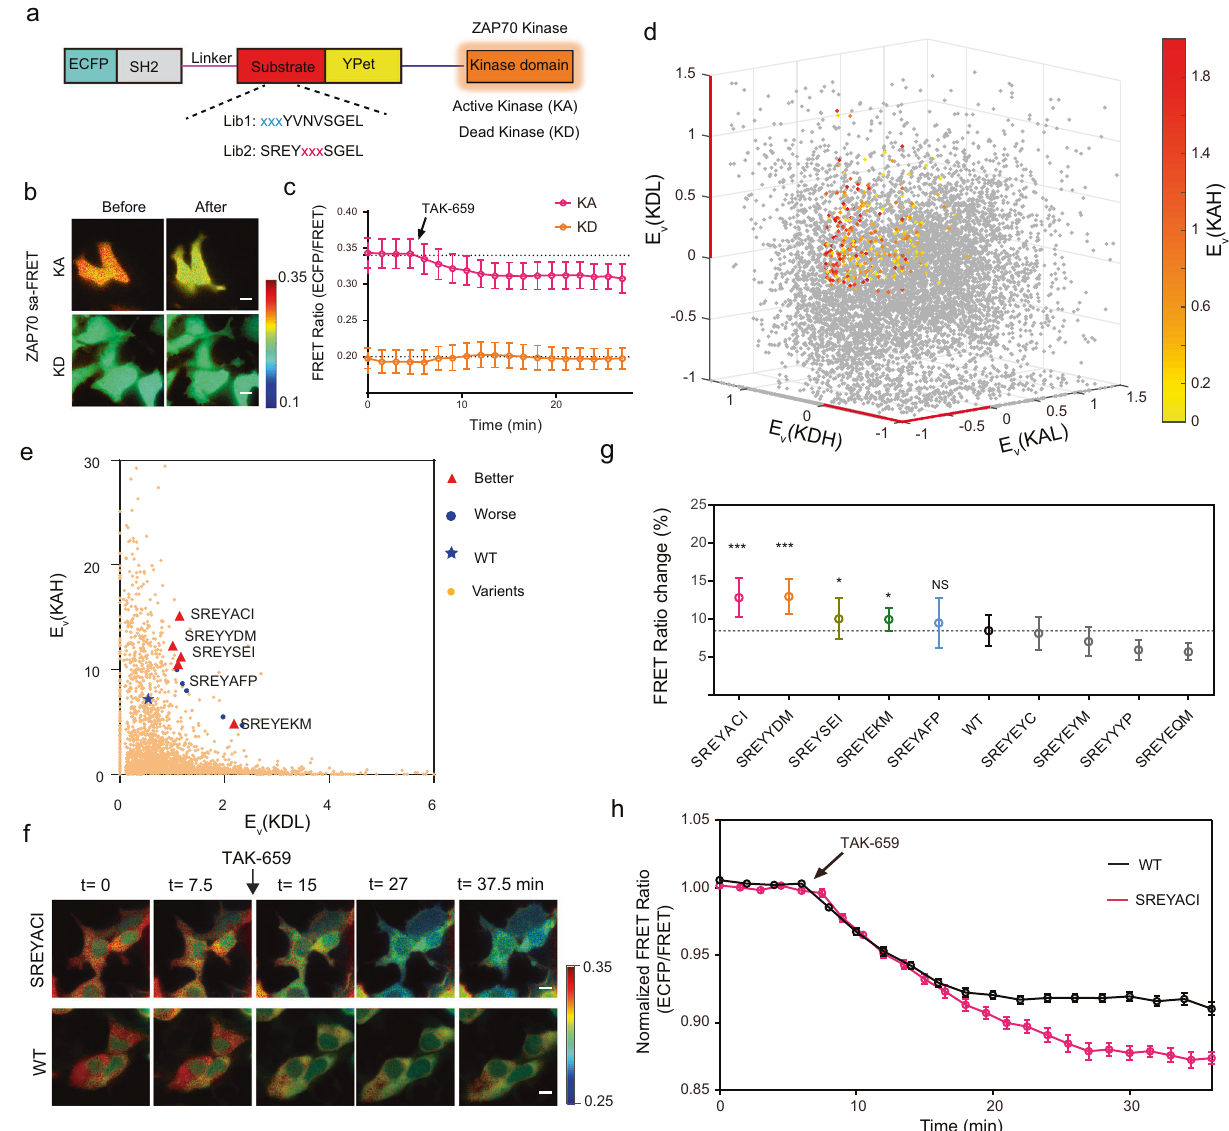
Fig. 3 Development and optimization of the ZAP70 FRET biosensor. a Design of the self-activating ZAP70 FRET biosensor as the screening template. b – c Representative images ( b ) and time courses ( c ) of FRET ratios of the ZAP70 saFRET biosensor with Active- (KA, n = 31) or Dead- (KD, n = 19) kinase domain, before and after TAK-659 treatment. Error bars, mean ± SD. Scale bars, 10 µ m. See also supplementary video 3. d, The 4D plot of the four enrichment ratios (E v ) of substrate sequences. The enrichment ratios in KAH group (E v (KAH)) were color-coded, whereas E v (KAL), E v (KDH), and E v (KDL) are plotted along the three-dimensional coordinates. The selected substrate sequences are highlighted with colors represented by the values of their E v (KAH). e Scatter plot of the substrates. The ZAP70 saFRET biosensors with the top 10 highest products of E v (KAH) and E v (KDL) were labeled in red (better biosensors) or blue (worse biosensors). f Time-lapse images of the parental (WT) and improved saFRET biosensors after TAK-659 treatment corresponding to the quanti fi ed time courses in ( h ). Scale bars, 10 µ m. See also supplementary video 4. g Percentage changes of saFRET biosensor variants after TAK-659 treatment (From left to right, n = 26,17,17,15,15,31,18,15,20, and 15, respectively, One-way ANOVA, compared to the WT group, *** P < 0.001, * P = 0.0192 and 0.0329, respectively, NS, not signi fi cant with a P = 0.138, only the varients with a mean value larger than the WT were subjected to statistical analysis). Error bars, mean ± SD. h Time courses of FRET ratio of the selected saFRET biosensor variant (SREYACI, n = 26), with that of the parental biosensor (WT, n = 44) marked in black. Error bars, Mean ± SEM. b , f The color bar indicates ECFP/FRET ratio, with hot and cold colors representing the high and low ratios, respectively. Source data are provided as a Source Data fi kinase activity was tracked by live-cell imaging after the CAR-T antigen stimulation (Fig. 5b – g). The ERK signals increased within cells expressing either WT-CAR or XX3-CAR were stimulated 5 min after antigen engagement and quickly reached a plateau with antigen-presenting CD19 + 3T3 cells (Fig. 5a). A large FRET (Fig. 5b – c). However, no signi fi cant difference in ERK activity ratio change of ERK and ZAP70 biosensors in both types of CAR- was observed between CAR-T cells expressing WT-CAR or XX3- T cells was observed when engaging with the CD19 + 3T3 cells; CAR (Fig. 5d). In contrast, a signi fi cantly delayed response and a this indicates that ZAP70 and ERK kinases are both responsive to reduced activation level of ZAP70 kinase activity were observed in